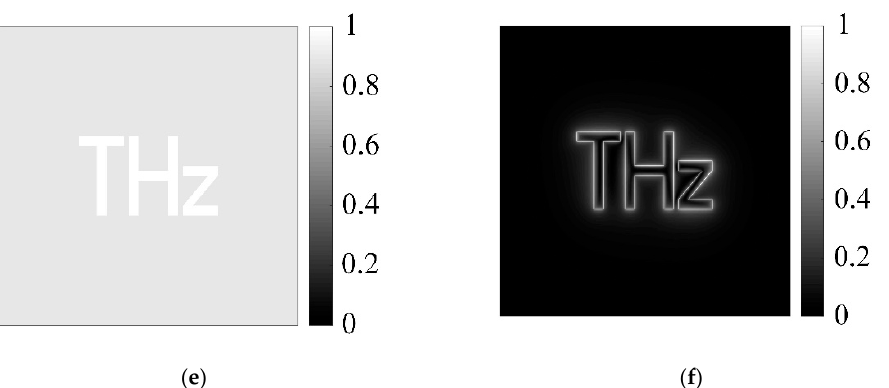
Figure 3. THz spiral spatial filtering imaging results of the simulated letters object of “THz”. ( a , c , e ) The letter objects with different image contrasts of 53.85, 25 and 5.26%. ( b , d , f ) The corresponding edge detection results of the outline profiles.